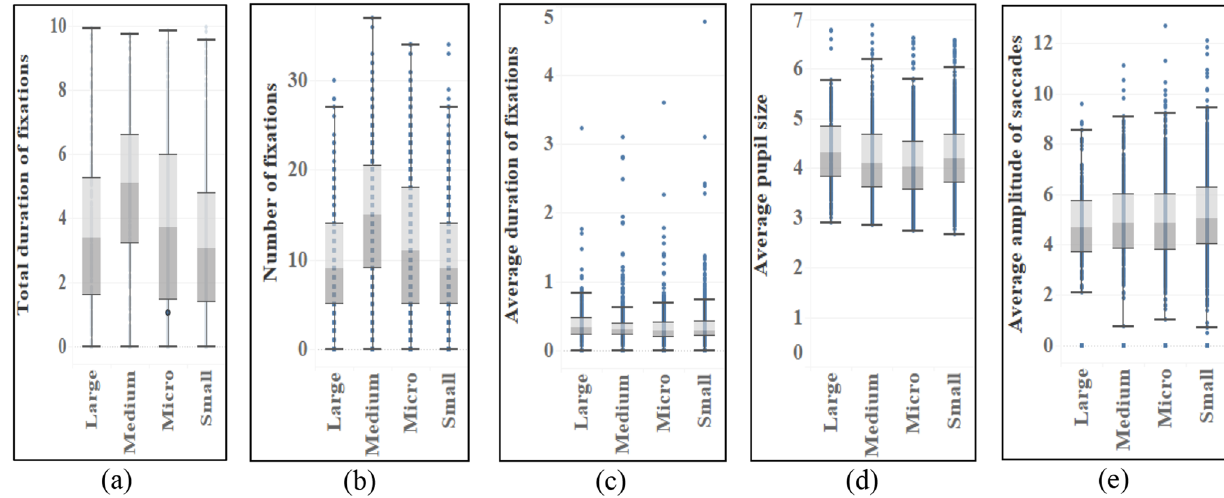
Figure 10. Eye movement indexes of different fruit sizes.